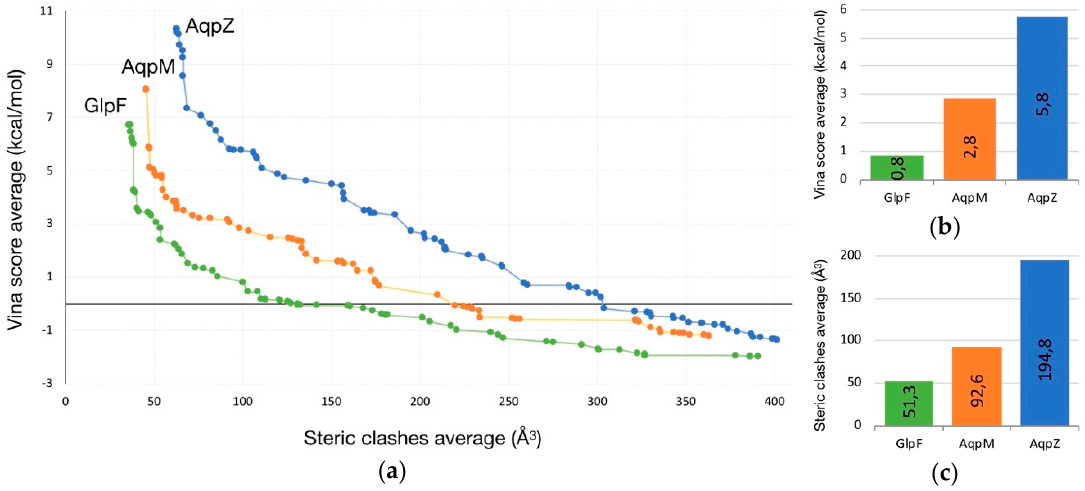
Figure 2. ( a ) Pareto front of solutions for di ff erent AQPs (GlpF in green, AqpM in orange, and AqpZ in blue). ( b ) Being fixed steric clashes to 100 Å 3 , Vina score for each AQP is represented. ( c ) Being fixed Vina score to 3 kcal / mol, steric clashes for each AQP is represented.